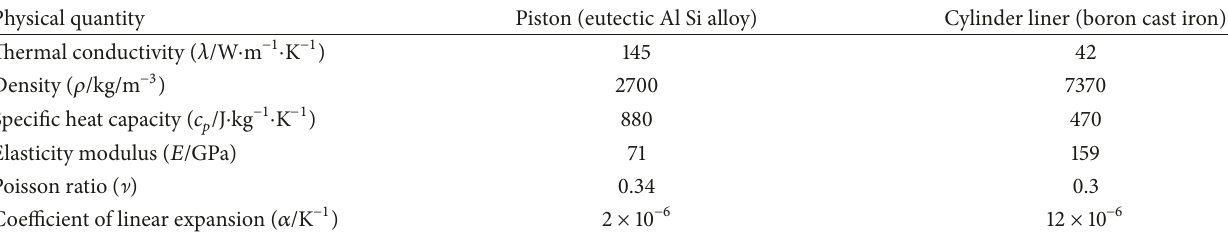
Table 3: Characteristic parameters of piston